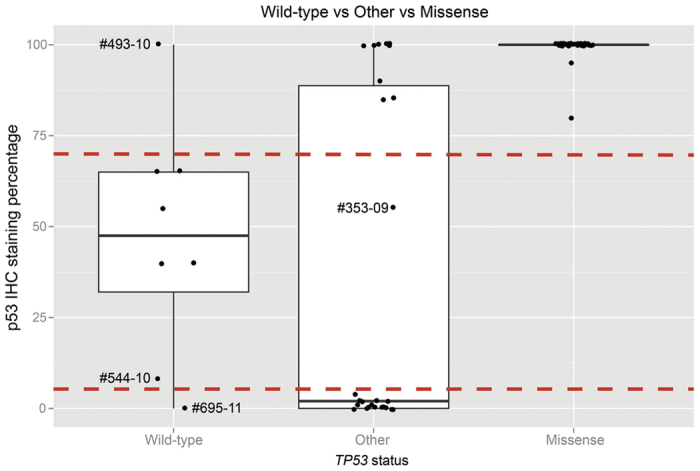
Correlation of wild-type and mutant p53 levels with TP53 mutation status (wild-type, missense and all ‘other’ mutations).While all missense TP53 mutants resulted in ≥70% tumour cell nuclei staining positive for p53, there was considerable variation amongst p53 staining patterns for wild-type (including both HGSOC and LGSOC) and non-missense TP53 mutations. While the majority of wild-type TP53 samples clustered between 8–65% tumour cell nuclei staining positive for p53 (denoted by the broken red line), one HGSOC sample demonstrated Low staining (#695-11; 0%) and one High (#493-10; 100%). Furthermore, there were two distinct clusters of non-missense mutations, with tumour cell nuclei staining positive for p53 between 80–100% and 0–4%, that could not further be discriminated by whether the mutations were nonsense, splice site, an in-frame insertion or frameshifts. Furthermore, a single nonsense mutation displayed 55% of tumour cell nuclei staining positive for p53 (#353-09).